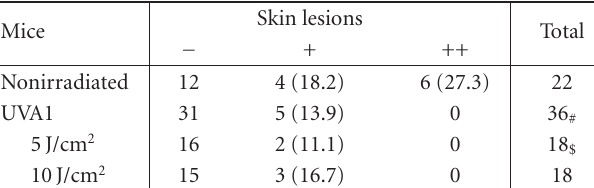
Table 1: E ff ects of UVA1 irradiation on the development of spontaneous LE-like skin lesions in MRL/lpr